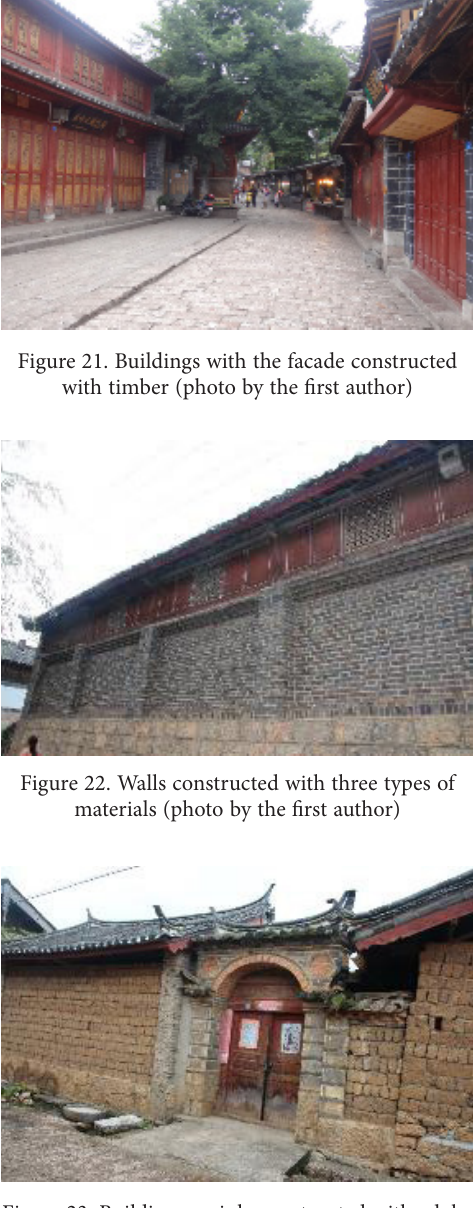
Figure 23. Buildings mainly constructed with adobe in a village of the Naxi (photo by the first author)